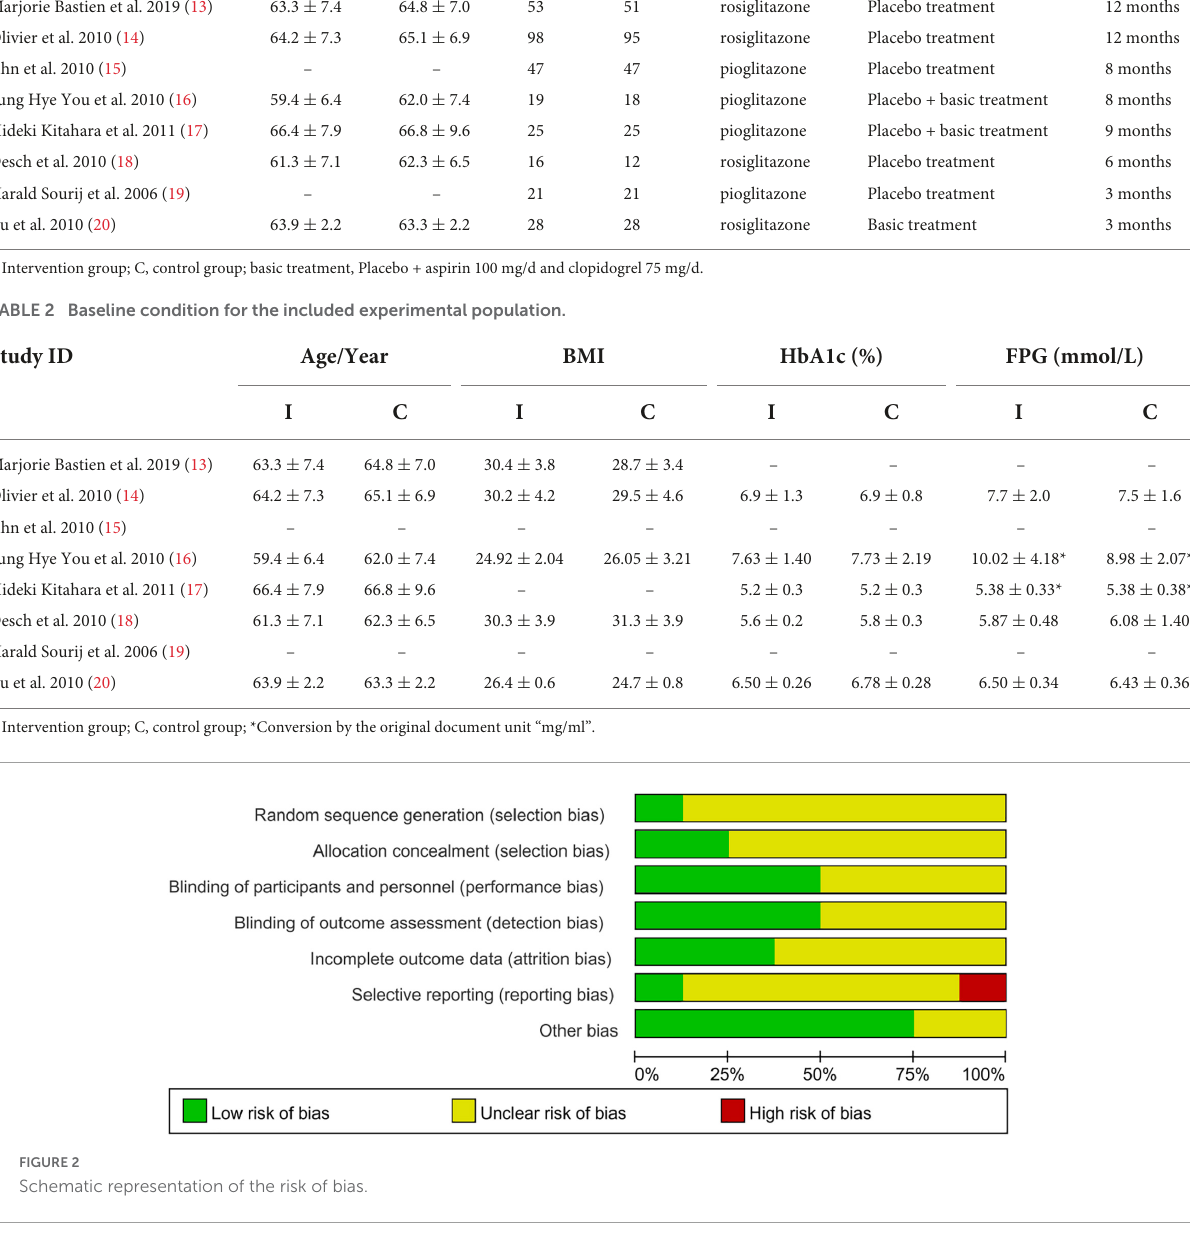
( Figure 4A ). Based on the random-effects model of meta- analysis, significantly higher levels of adiponectin were observed in the intervention group compared to the control